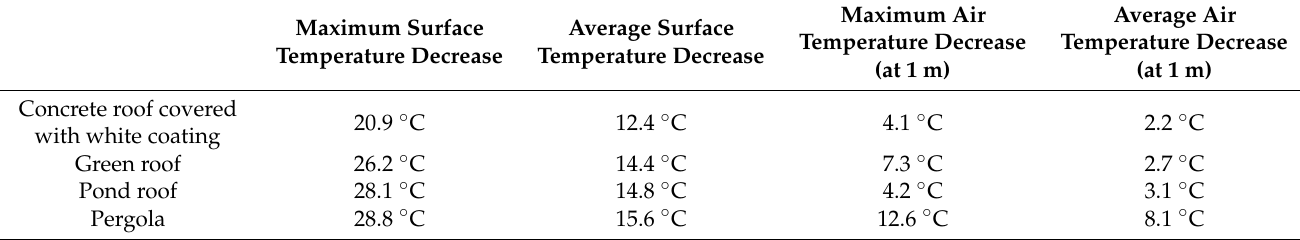
Table 2. Performance of the four roofs in the hot and dry climate (Athens) [23].